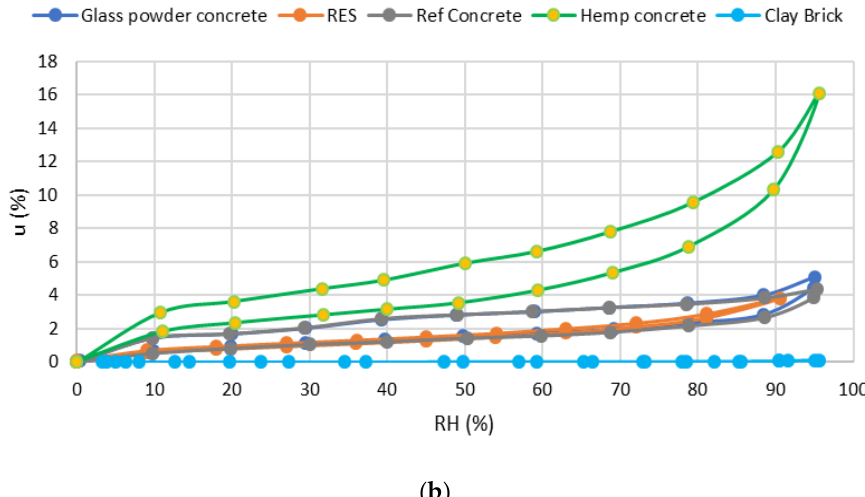
Figure 13. Comparison of sorption isotherms of concrete, glass powder concrete, hemp concrete, clay brick, and raw earth/straw (RES) in terms of water content ( a ) and mass ratio ( b ). The incorporation of plant fibers within raw earth has increased the moisture storage capacity of the RES samples (Figure 14). This value was compared with those of hemp concrete and concrete. Moisture storage capacity of RES specimens is the highest of materials being studied, reaching a value of 203 kg · m − 3 at 78% of RH against 151, 117, and 108 kg · m − 3 for hemp concrete, glass concrete, and conventional concrete, respectively.